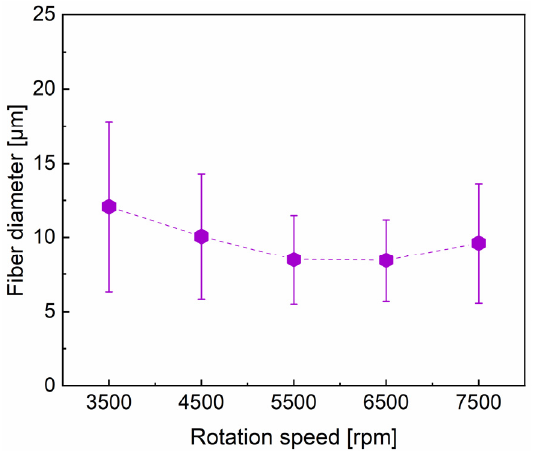
Figure 6. The diameter of PVA fibers prepared under different rotation speeds.